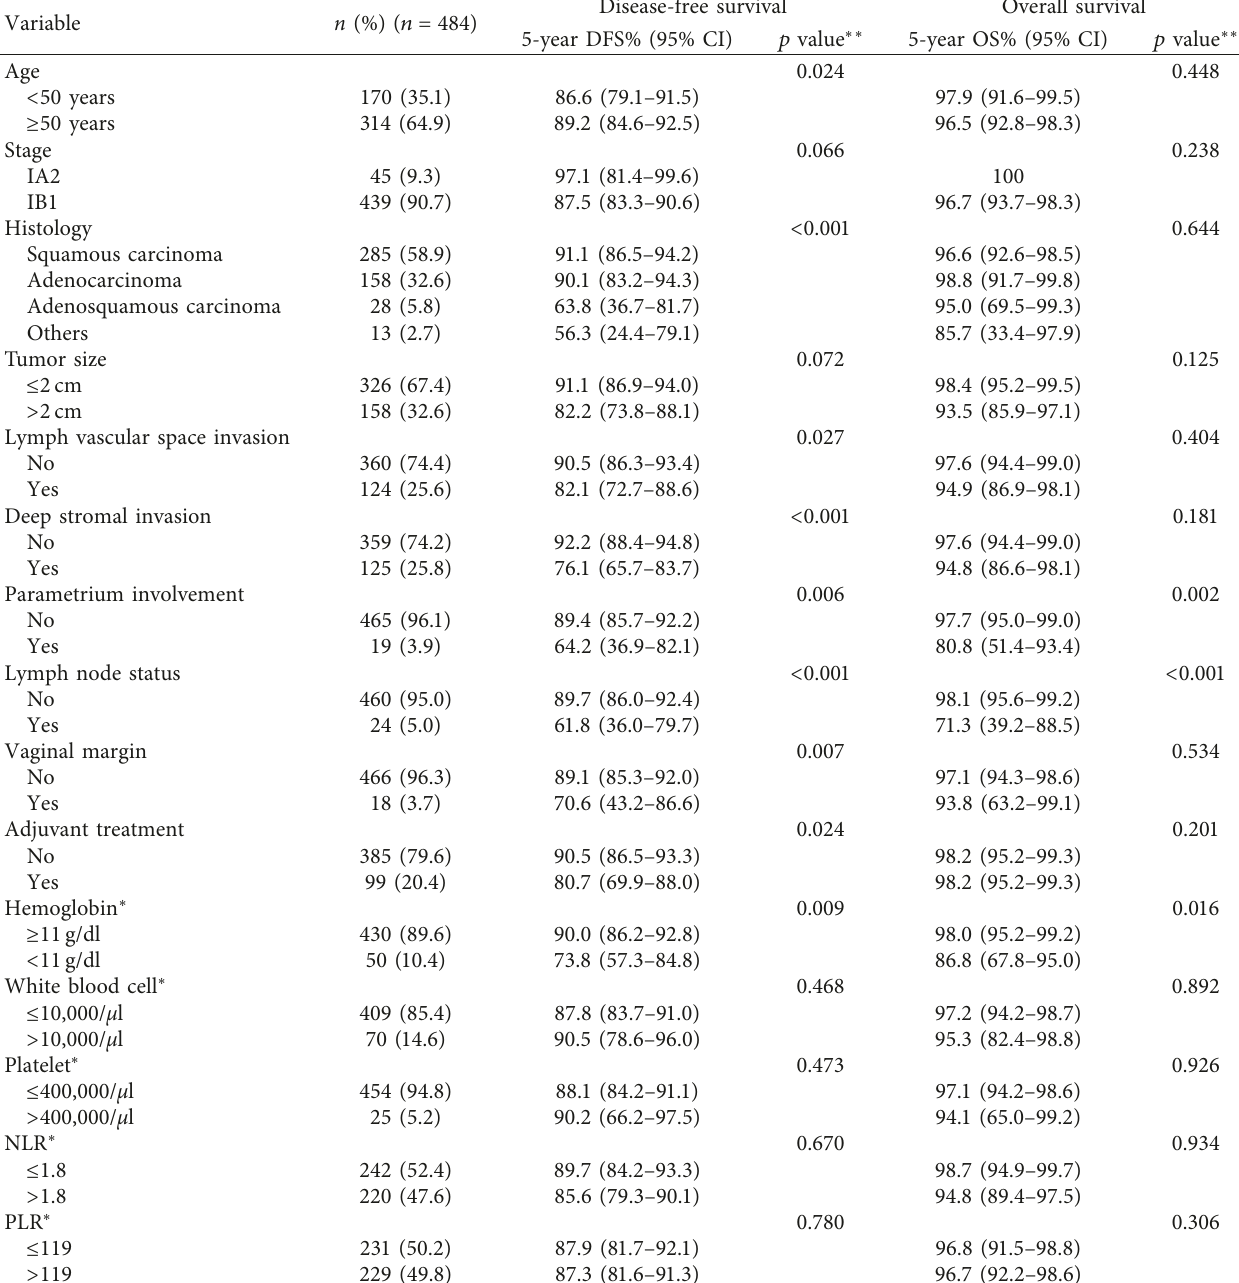
Table 3: Univariate analysis of disease-free survival and overall